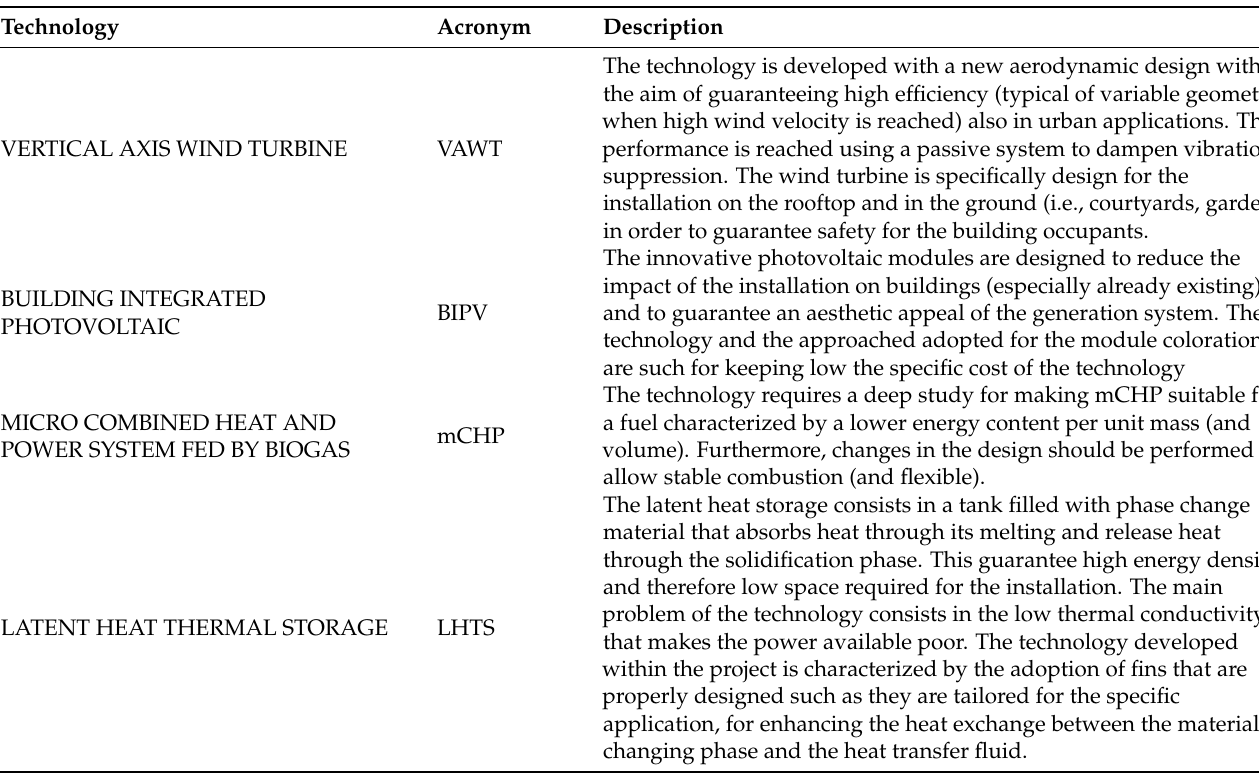
Table 1. RES considered in the RE-COGNITION project.